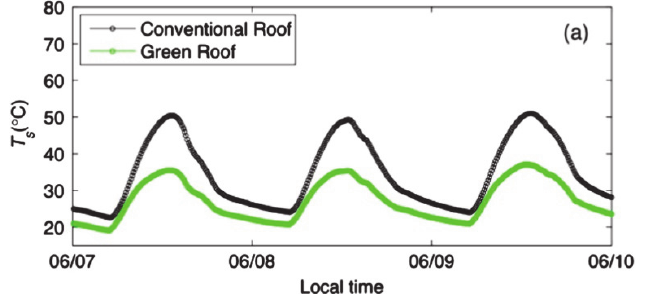
Fig. 3. Comparison of internal temperature in the construction with a conventional roof and another with a green roof (Li et al.,